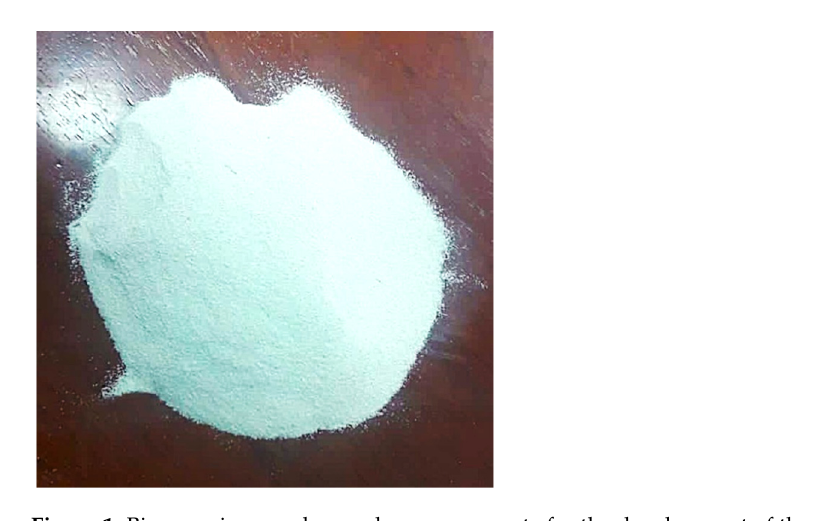
Figure 1. Bioceramics powder used as an aggregate for the development of the new mortars.